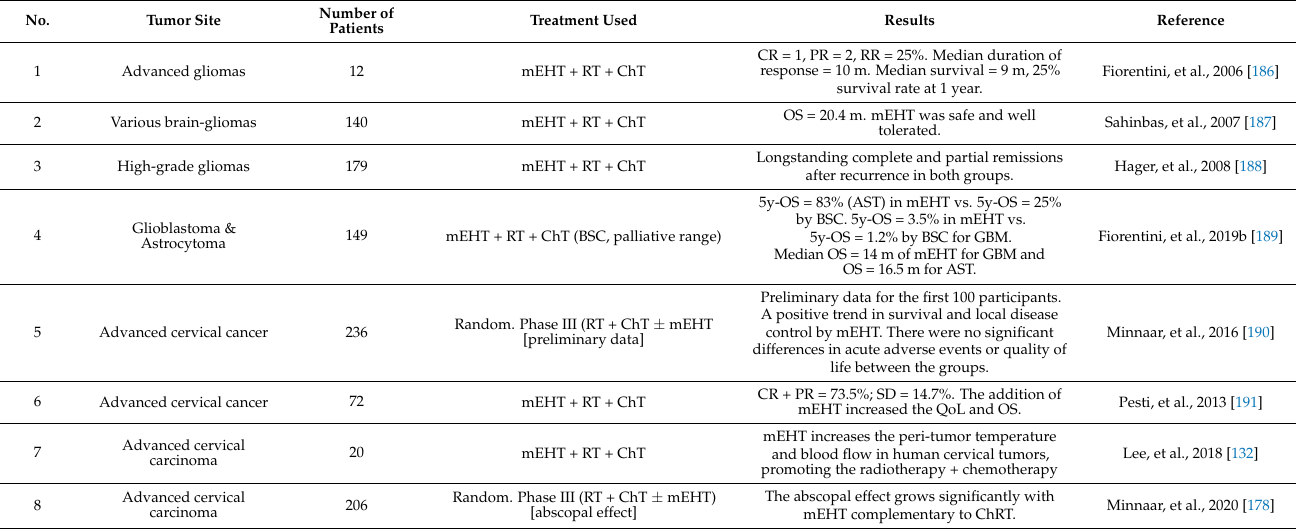
Table 2. The table refers only to the clinical results obtained with mEHT complementary to RT or